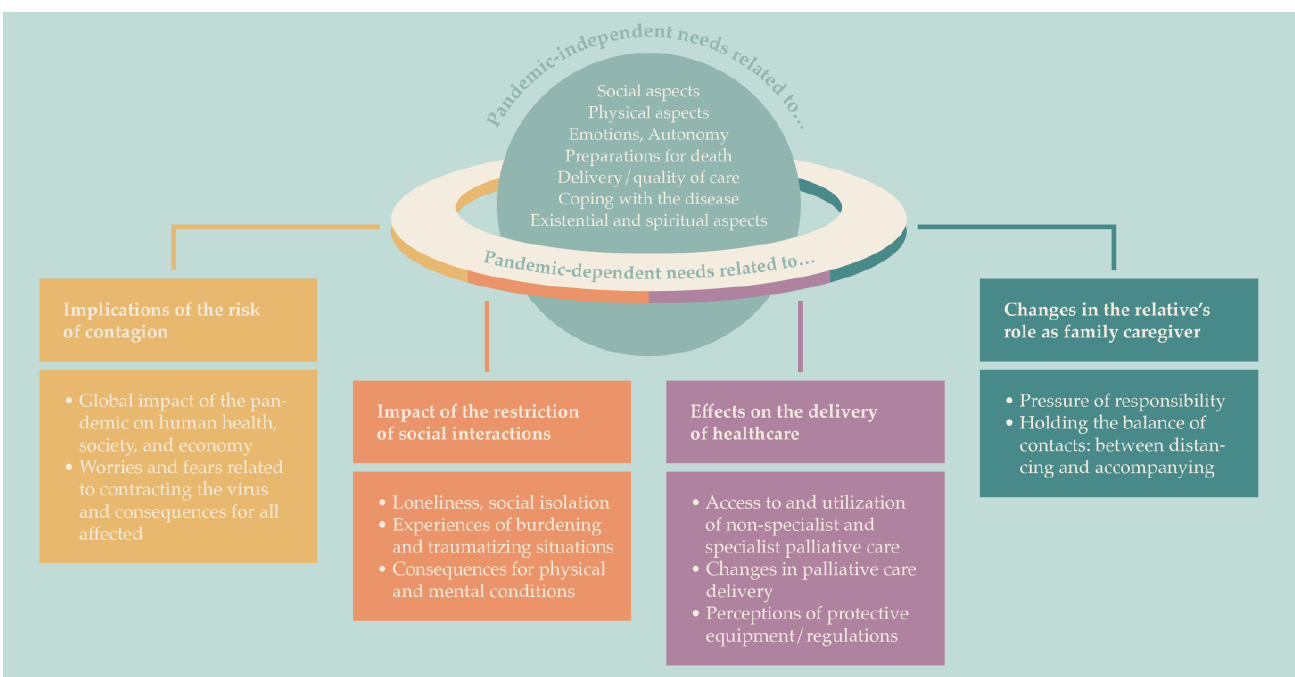
Figure 1. Themes of pandemic-dependent needs.